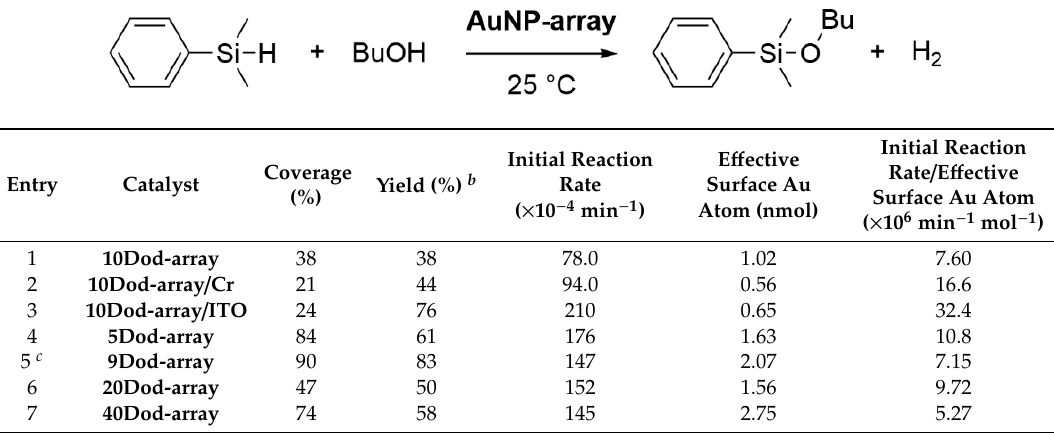
Table 1. Various AuNP-array-catalyzed butanolyses of DMPS a .